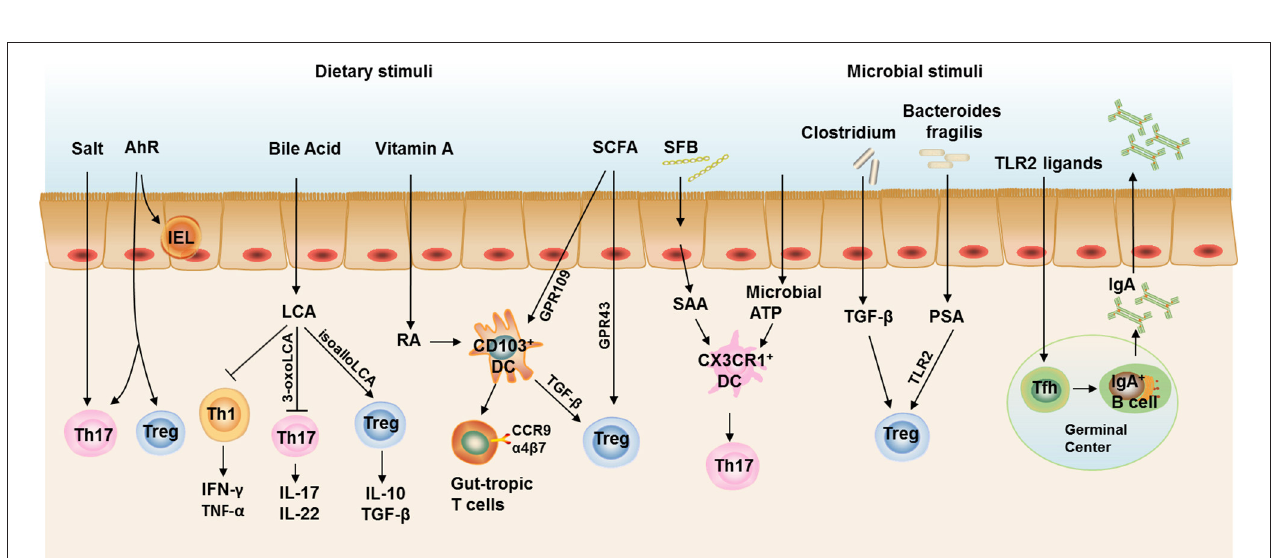
FIGURE 2 | Intestinal T cell immune responses under steady state. Th17 cells and Treg cells are the most abundant CD4 + T cells in the gut to maintain intestinal homeostasis. Excessive salt intake and AhR ligation both contribute to the increased Th17 cell polarization in the gut, while AhR ligation also required for the induction of Treg cells and maintenance of IELs. Bile acids are cholesterol-derived natural surfactants abundant in the mammalian gut. Lithocholic acid, a secondary metabolite of bile acids, impedes Th1 activation and two distinct derivatives of lithocholic acid, 3-oxo-lithocholic acid and isoallo-lithocholic acid, have been found to impair the differentiation of Th17 cells and increase the differentiation of Treg cells, respectively. CD103 + DCs represent the dominant DC population in the murine small intestinal lamina propria (SILP). CD103 + DCs induce the gut-homing receptors CC chemokine receptor (CCR)9 and α 4 β 7 on responding T cells and Treg cell differentiation, both of which are dependent on signaling events initiated by the vitamin A metabolite, retinoic acid (RA). Short-chain fatty acids (SCFAs) could also induce Treg polarization directly through a receptor GPR43 on T cells or indirectly through a receptor GPR109 on CD103 + DCs. Segmented filamentous bacteria (SFB) induce serum amyloid A (SAA) production from gut epithelial cells and stimulates CX3CR1 + DCs to promote Th17 cell development in the gut, the latter process could also be induced by commensal organism-derived ATP stimulation. Clostridium strains provide an environment rich in TGF- β that induces IL-10-producing colonic Treg Cells. Bacteroides fragilis ( B. fragilis ) promotes the differentiation and function Treg via its immunomodulatory molecule polysaccharide A (PSA), where Toll-like receptor 2 (TLR2) signaling is required. TLR2 ligand could also stimulate Tfh development in the germinal center to facilitate IgA production by B cells. Taken together, IL-17 and IL-22 produced by Th17, IL-10 and TGF- β produced by Treg cells, and IgA in the gut lumen constitute an immune barrier in maintaining gut homeostasis in steady state.